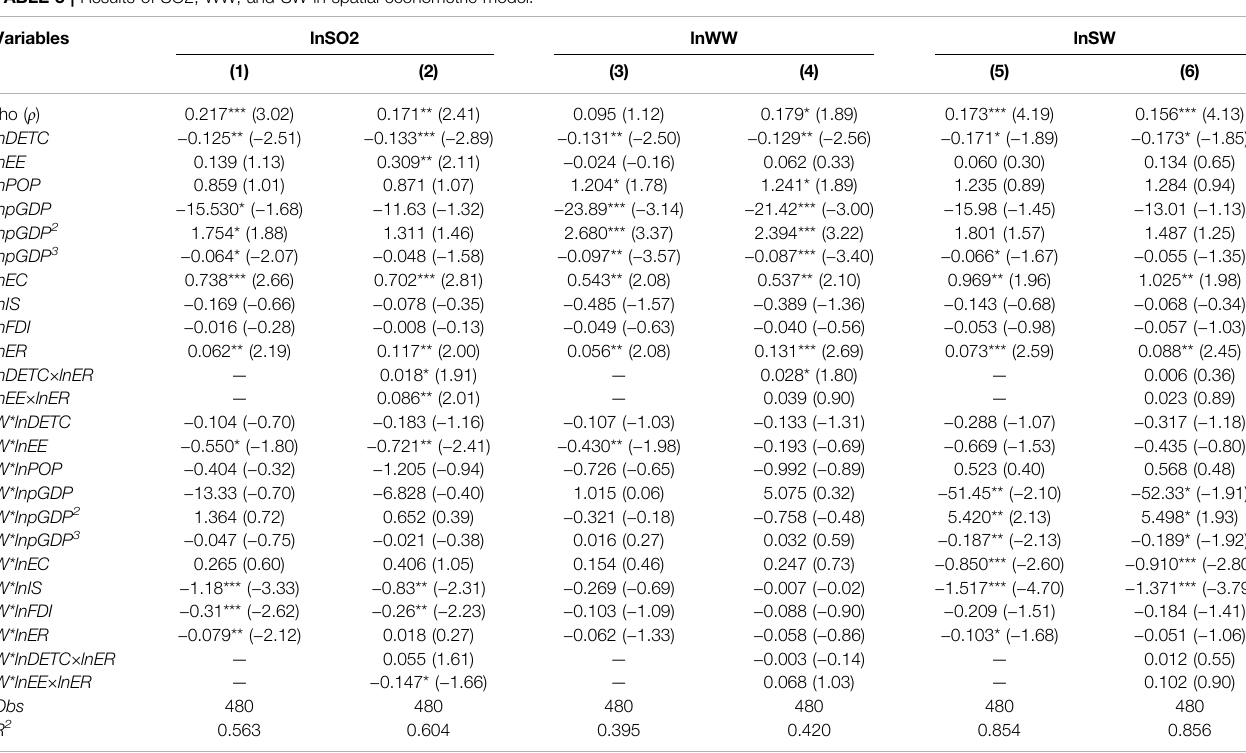
TABLE 3 | Results of SO2, WW, and SW in spatial econometric